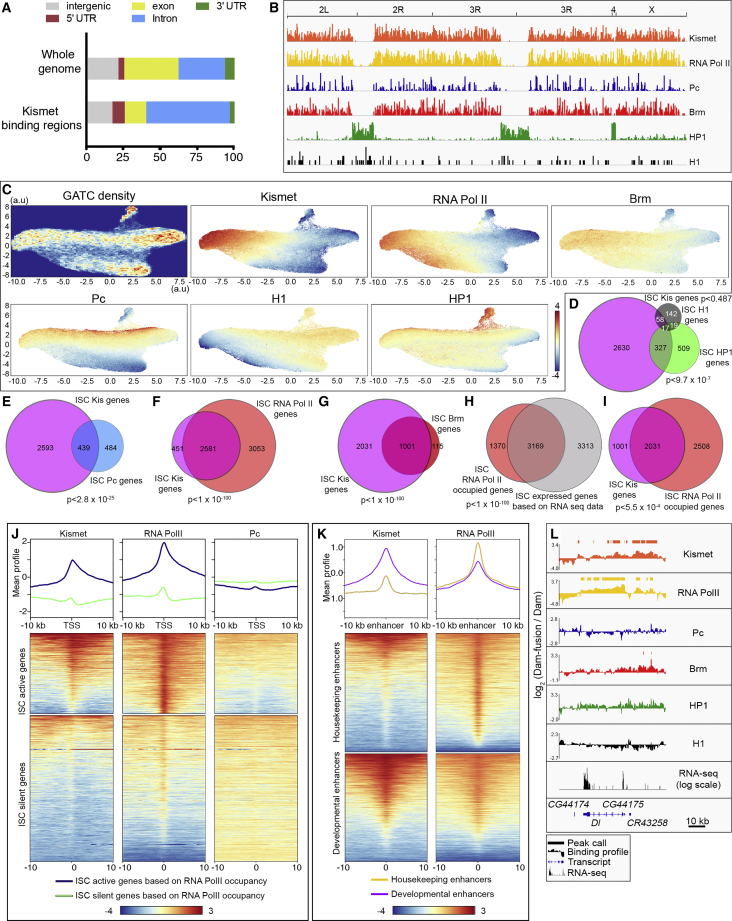
Genome-wide Mapping of Kismet Relative to RNA Pol II, Brm, Pc, HP1, and H1(A) Kismet DamID-seq showed an enrichment of methylated GATCs in the introns and 5′UTRs of genes. Unassembled regions of the genome were not considered.(B) Genome-wide overview of the DamID binding peak density in ISCs of Kismet, RNA Pol II, Polycomb (Pc), Brahma (Brm), HP1, and H1.(C) UMAP clustering of GATC sites based on 7 DamID fusion proteins (see STAR Methods) in the ISC. Density of GATC sites throughout the genome used for clustering followed by the plots representing the binding of each protein over GATC sites.(D–I) Venn diagrams of genes with peaks of the DamID-seq data in ISCs: Kismet versus HP1 or H1 (D) versus Pc (E) versus RNA Pol II (F) and versus Brm (G). Genes with a significant mean RNA Pol II occupancy determined by DamID versus transcriptionally active genes based on RNA-seq from Dutta et al., 2015 (H) and versus genes with peaks of Kismet (I).(J) Mean position and metaplot of Kismet, RNA Pol II, and Pc in ISCs relative to the TSS for genes classified by their activity based on RNA Pol II occupancy. Kismet was significantly enriched over the TSS of active genes.(K) Mean position and metaplot of Kismet and RNA Pol II in ISC relative to previously defined “developmental” or “housekeeping” enhancers in S2 cells from Zabidi et al., 2015. Kismet was found enriched over developmental enhancers.(L) Wild-type RNA-seq, Dam-Kis, Dam-RNA Pol II, Dam-Pc, Dam-Brm, Dam-HP1, and Dam-H1 ISC binding profiles and peaks alignments over the genomic region surrounding the ISC-specific gene Delta.